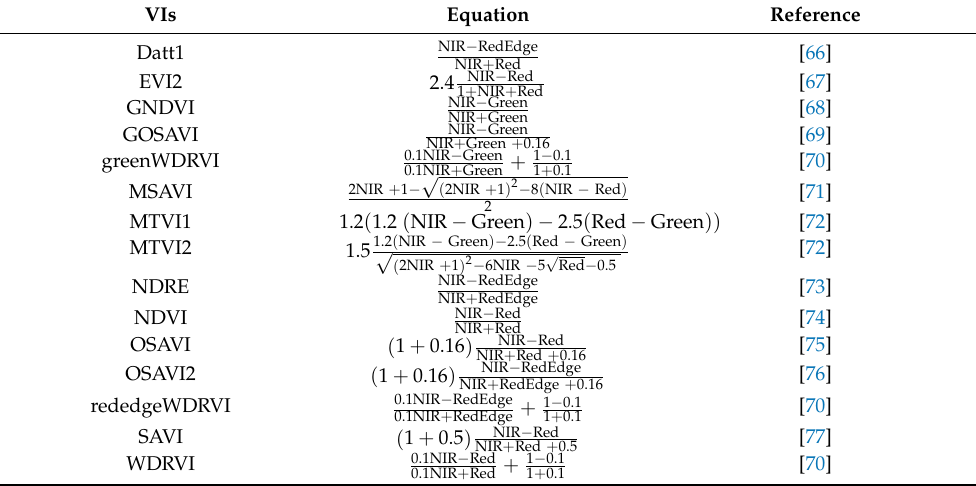
Table 2. List of the vegetation indices evaluated in random forest models for crop traits estimation and yield prediction of Miscanthus